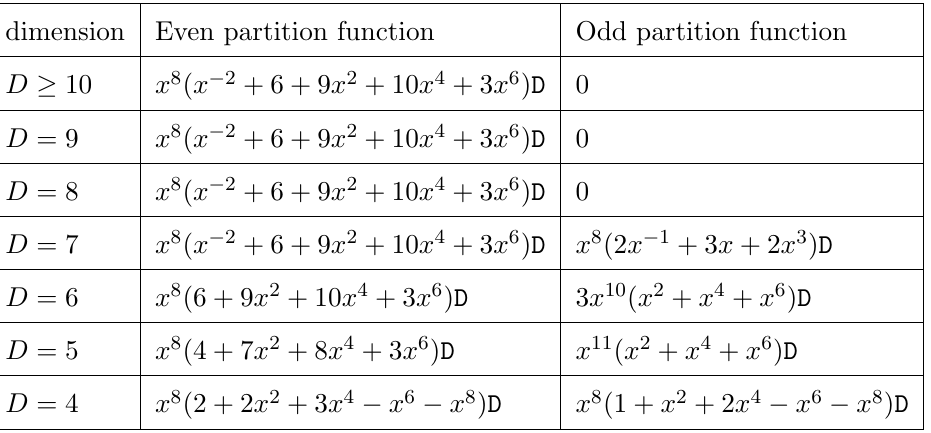
. (1 (cid:0) x 4 )(1 (cid:0) x 6 )